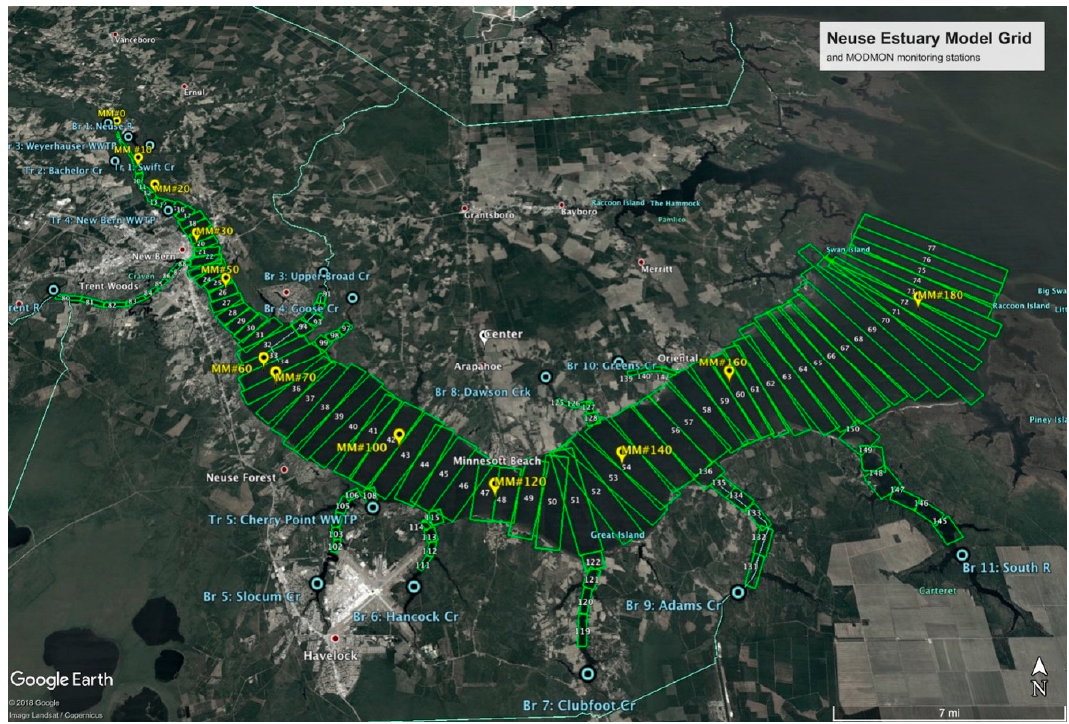
Figure 1. W2 model grid and IMS ModMon monitoring stations.